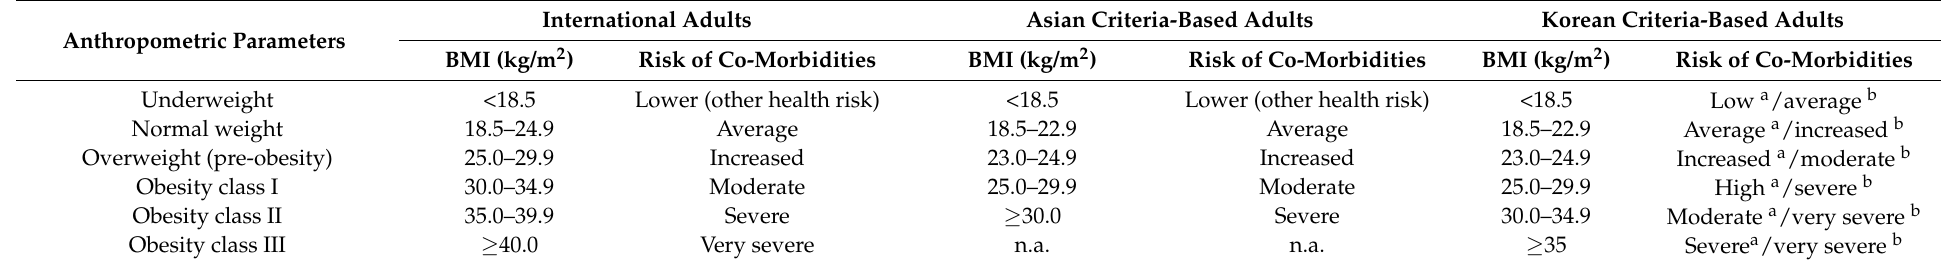
Table 1. Classification of body mass index (BMI; kg/m 2 ) and the risk of co-morbidities in international, Asian, and Korean criteria-based adults according to the WHO [19,20] and Seo et al. [21],